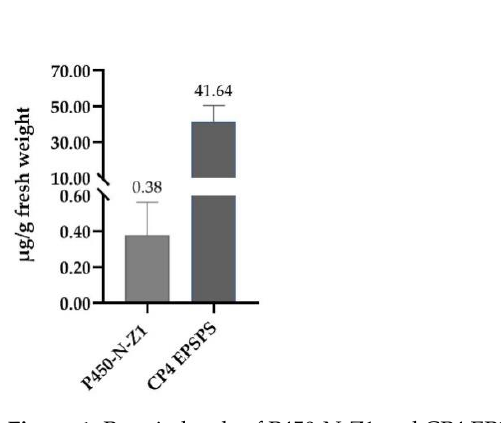
Figure 1. Protein levels of P450-N-Z1 and CP4 EPSPS in ZDAX5 grain.